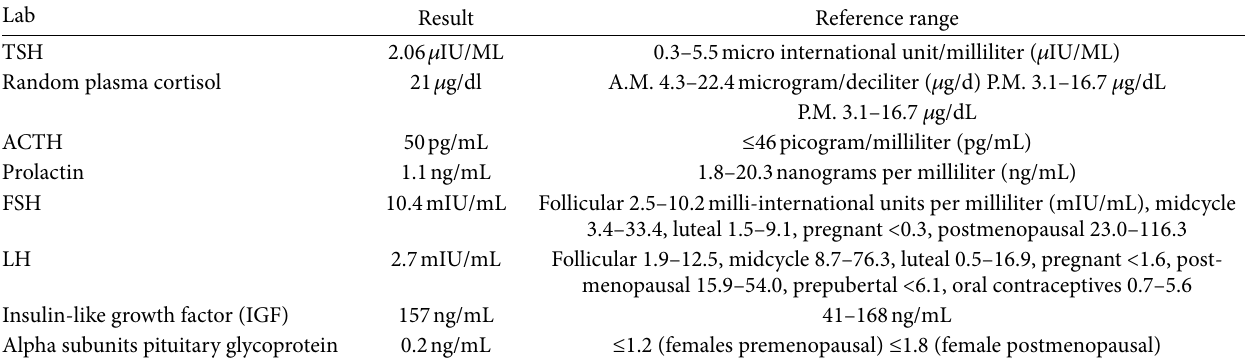
2: MRI head with contrast T1. (a) Sagittal view showing an enlarged pituitary gland. It measures 1.9 × 2.0 cm in the greatest dimension. The mass is slightly heterogeneous in signal and is slightly impressing on the optic chiasm. (b) and (c) Coronal view with different cuts showing extension on the left cavernous Table 1: Hormonal workup.